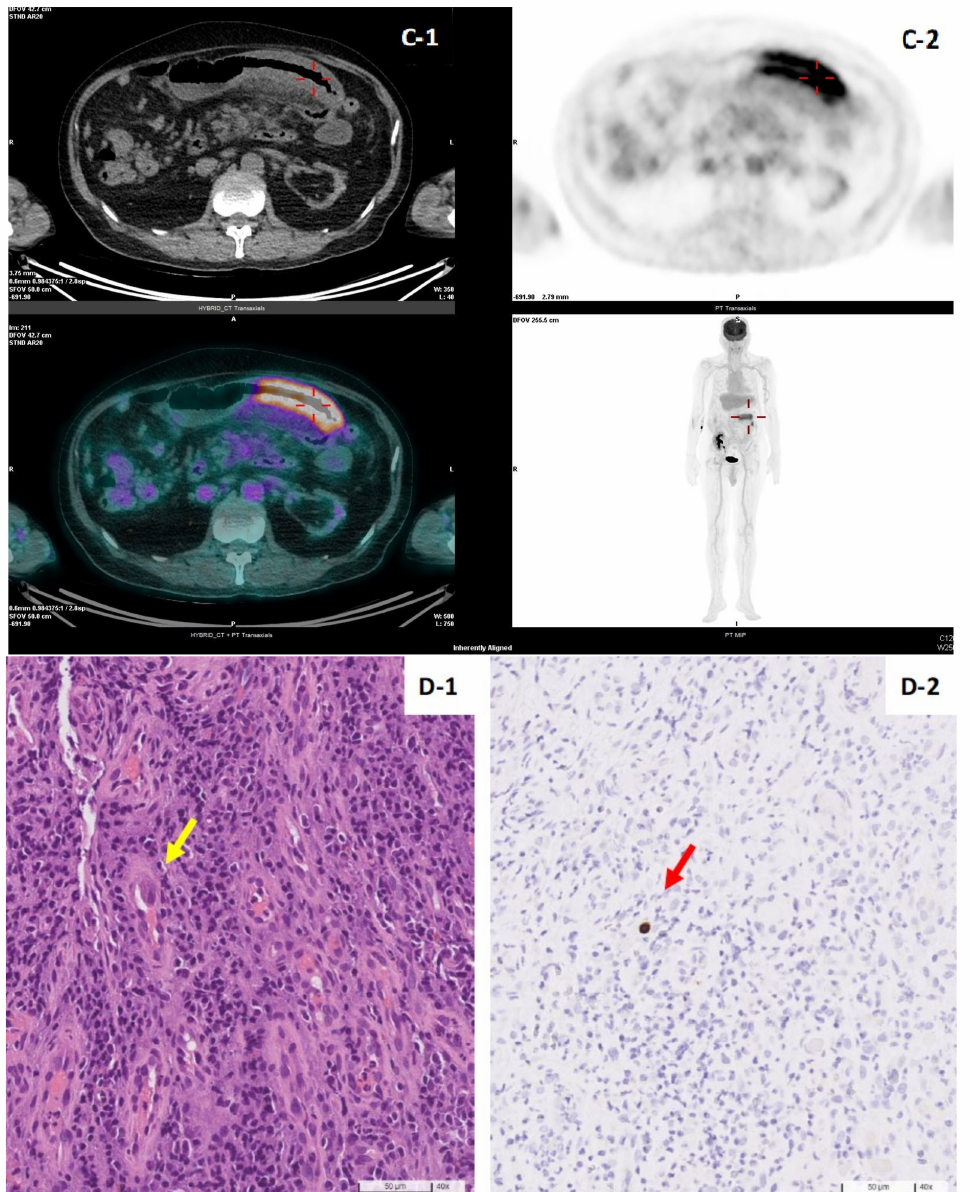
Figure 2. ( A , B ). Colonoscopy features of living donor liver transplant patient No.1. Well-demarcated longitudinal ulceration (around 3 cm in diameter) in descending colon with colonic mucosa ede- matous change and bowel wall thickening, causing intra-luminal narrowing ( A-1 , A-2 ). Remission of ulceration 2 weeks later after antiviral therapy follow-up ( B-1 , B-2 ). ( C ). Positron Emission To- mography/Computed Tomography (PET/CT) of patient No.1. PET/CT illustrated segmental colon wall thickening at distal T-colon and proximal D-colon by CT scan ( C-1 , arrow) and increased FDG uptake in the colon wall, SUV max:7.6 by PET ( C-2 , arrow), respectively. ( D ). Histopathology of CMV colitis in patient No.1. Histological hematoxylin and eosin staining ( × 40 objective) detection of CMV inclusion bodies (owl’s eye) (yellow-arrow), biopsy specimen of an ulcer at descending colon ( D-1 ). Positive CMV immunohistochemistry (IHC) staining ( × 40 objective) (red-arrow) ( D-2